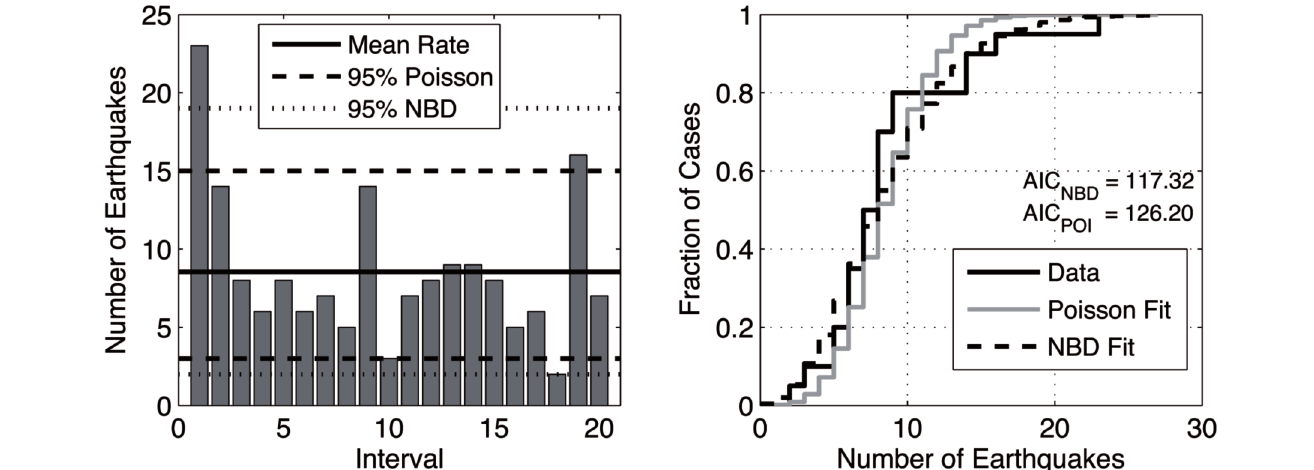
Figure 1. Left: Observed number of earthquakes in the 20 non-overlapping five-year intervals in the CPTI, from 1907 to 2006 (inclusive). Solid line, mean number of observed events; dashed lines enclose the 95% confidence interval of the Poisson distribution; dotted lines, the 95% confidence interval of the negative binomial distribution (NBD). Right: Cumulative distribution functions. Solid black line, observations; solid gray line, data fit with a Poisson distribution; dashed black line, data fit with a NBD. The Akaike Information Criterion (AIC) values of the fitted distributions are also